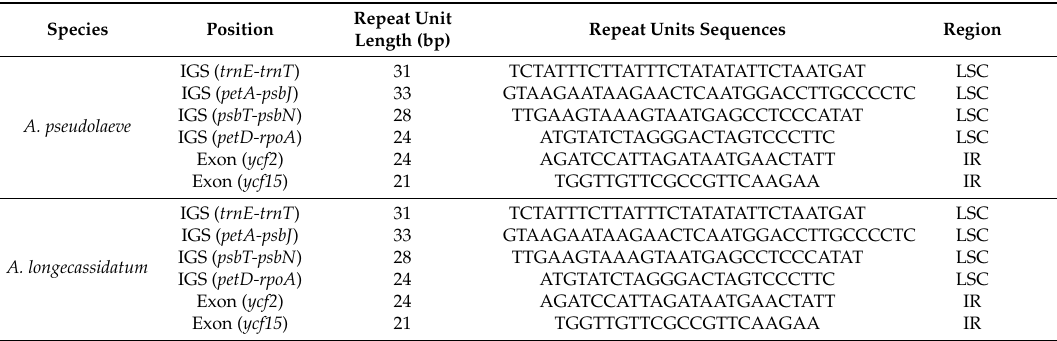
Table 5. Distribution of palindromic repeats in the CP genomes of A. pseudolaeve Nakai